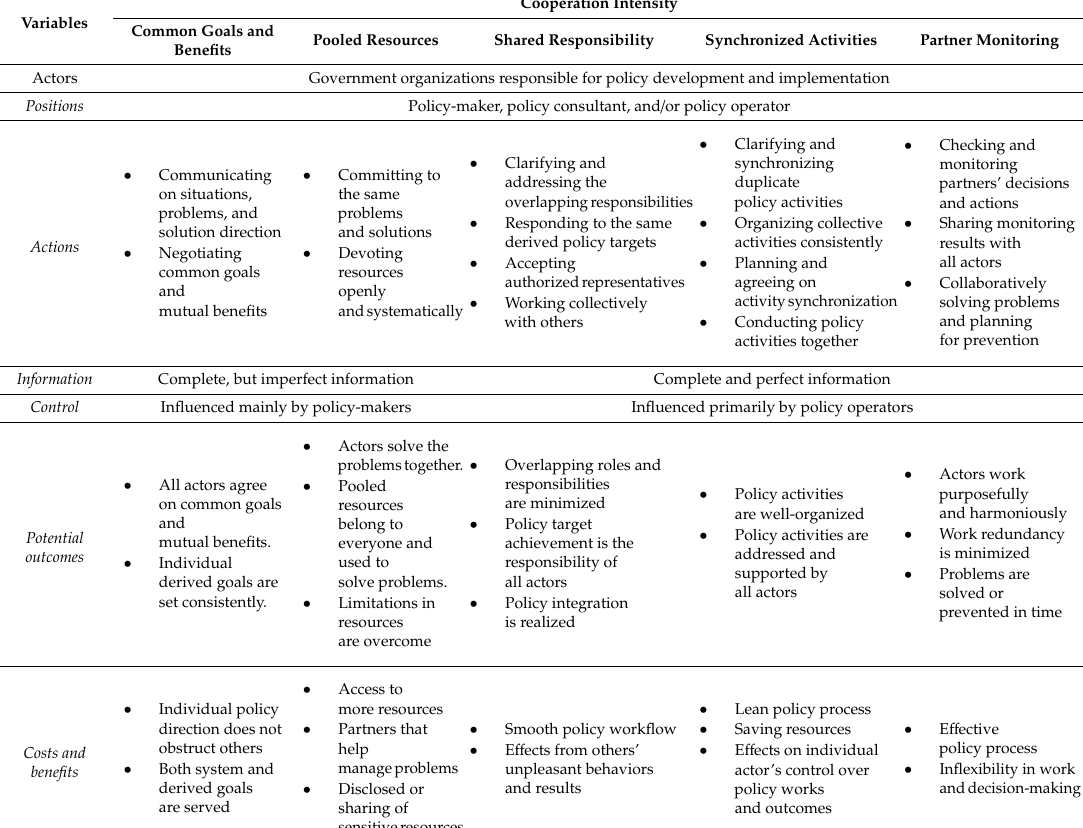
Table 8. Comparison of the internal structure of the action situation at di ff erent cooperation intensities.